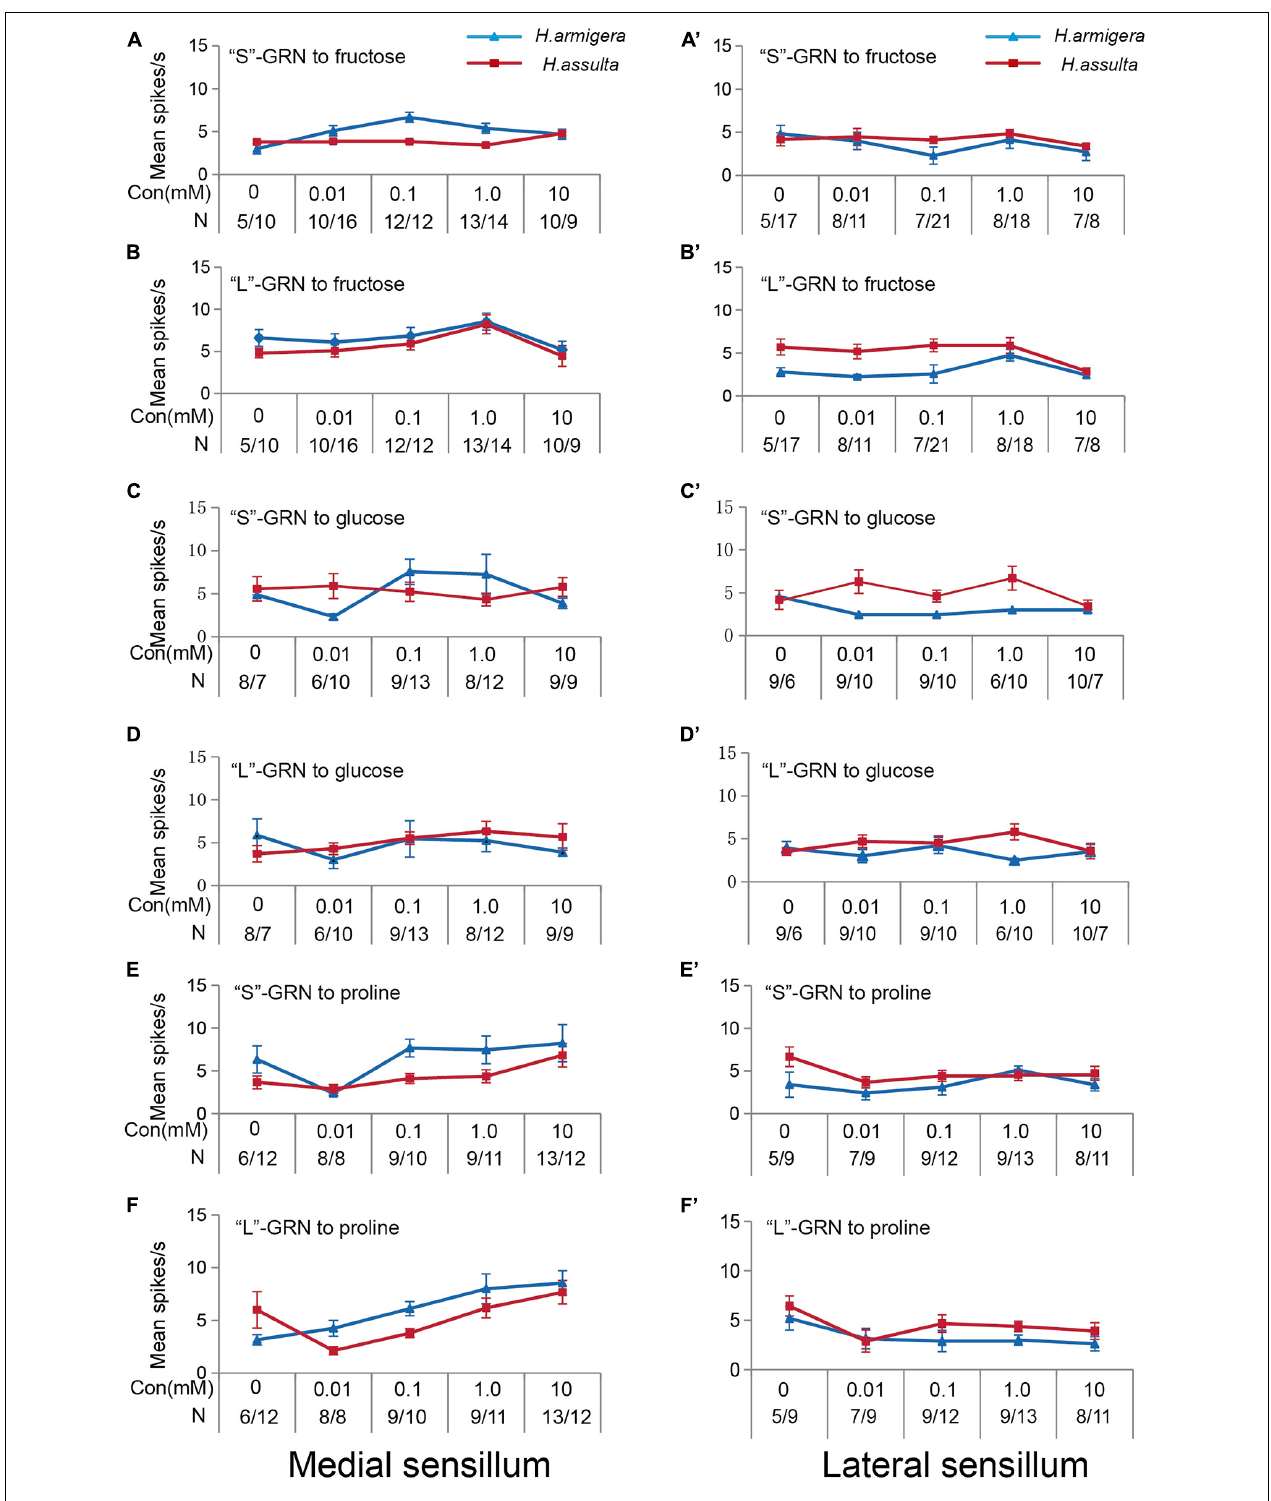
FIGURE 3 | Responses of “S” and “L” GRNs in the styloconic sensilla of Helicoverpa caterpillars to the three primary metabolites. (A,C,E) : responses of the indentified “S” GRNs from the medial sensillum to fructose, glucose, and proline, respectively; (B,D,F) : responses of the indentified “L” GRNs from the medial sensillum to fructose, glucose, and proline, respectively; (A’,C’,E’) : responses of the indentified “S” GRNs from the lateral sensillum to fructose, glucose, and proline, respectively; (B’,D’,F’) : responses of the indentified “L” GRNs in the lateral sensillum to fructose, glucose, and proline, respectively.